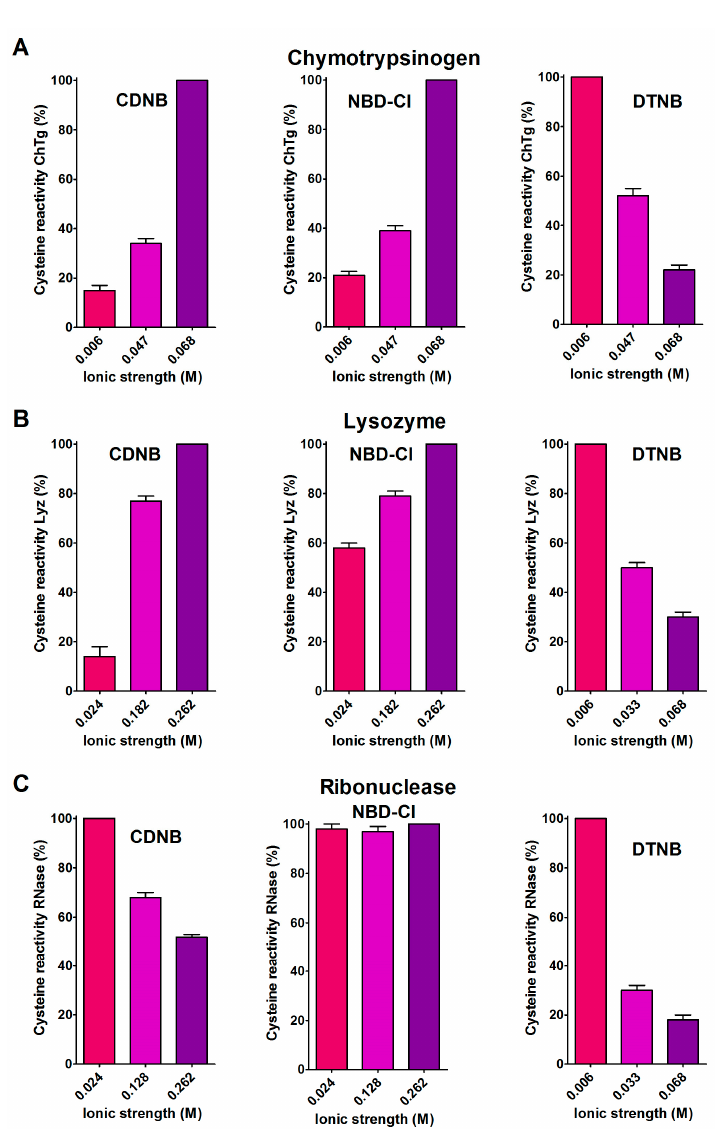
Figure 4. E ff ect of ionic strength variation on the reactivity of the reduced chymotrypsinogen, lysozyme and ribonuclease. ( A ) The change of the hyper-reactivity due to ionic strength variation was assayed for rChTg’s reaction with CDNB, NBD-Cl and DTNB at pH = 5.0, as reported in Section 4. ( B ) A similar experiment was performed with rLyz for the reaction with CDNB and NBD-Cl at pH = 7.4 and DTNB at pH = 5.0. ( C ) The change of the hyper-reactivity due to ionic strength variation was assayed for rRNase’s reaction with CDNB and NBD-Cl at pH = 7.4 and DTNB at pH = 5.0. The details are reported in Section 4. The data are the Mean ± S.D. of three independent experiments. Finally, seven cysteines in the reduced form of bovine serum albumin (rBSA) also display 140- times enhanced reactivity toward CDNB, when compared to that of an unperturbed protein cysteine (Figure 5A) [14]. The expected maximum implementation, calculated on the basis of the p K a variations (p K a = 7.8 for 7 Cys), is about four-times (Figure 5B). Thus, 35-times is the enhanced reactivity due to hydrophobic interactions (Figure 5C and Table 1).